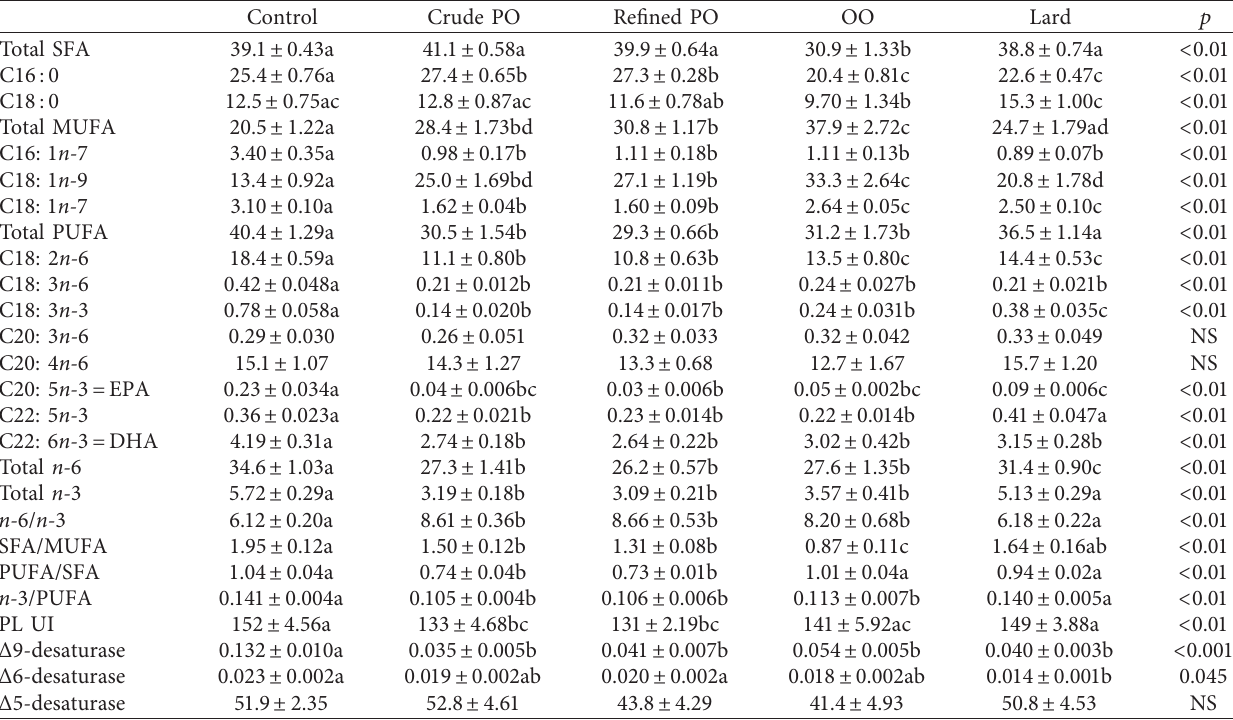
Table 4: Effect of diets on liver mitochondrial phospholipid (PL) fatty acid (FA). Control Crude